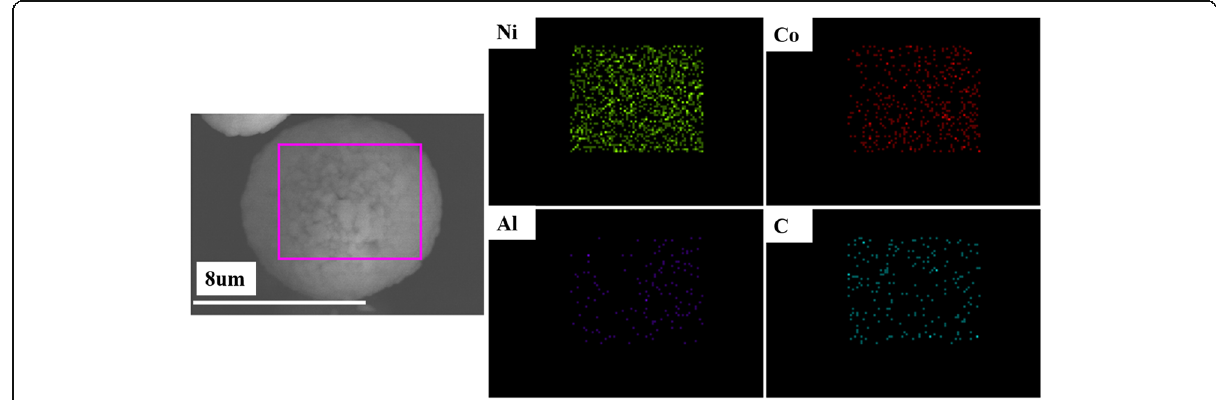
Fig. 2 EDS dot-mapping images of Ni, Co, Al, and C elements of NCA/CNT (10 wt%)